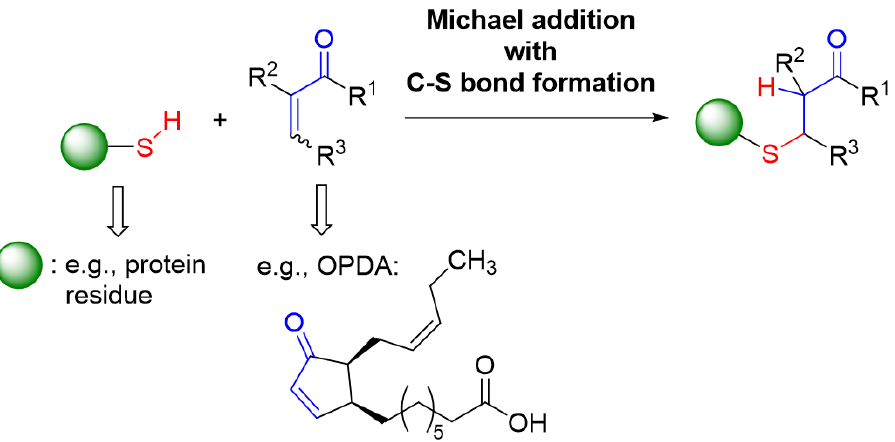
Figure 13. General reaction scheme for the addition of a thiol moiety (e.g., being present in a protein) to an α,β -unsaturated carbonyl compound as a Michael acceptor such as, e.g., OPDA.